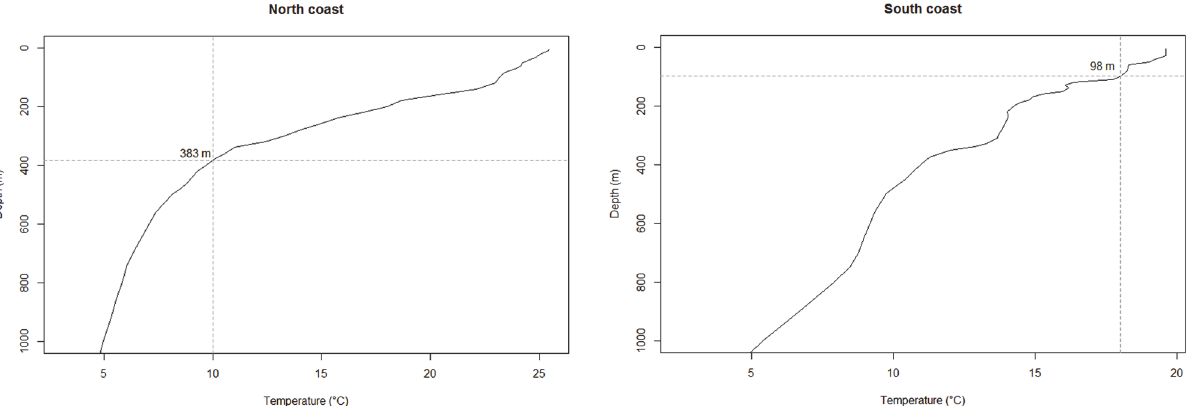
Fig 6. Vertical profiles of water temperature. Plots show temperature profiles recorded by Argo floats of the north (17.6°S 117.6°E) and south (35.78°S 119.5°E) sections of the WA coast. Vertical lines represent the minimum temperature reported by the shark ’ s satellite transmitter and horizontal lines represent the estimated diving depth.